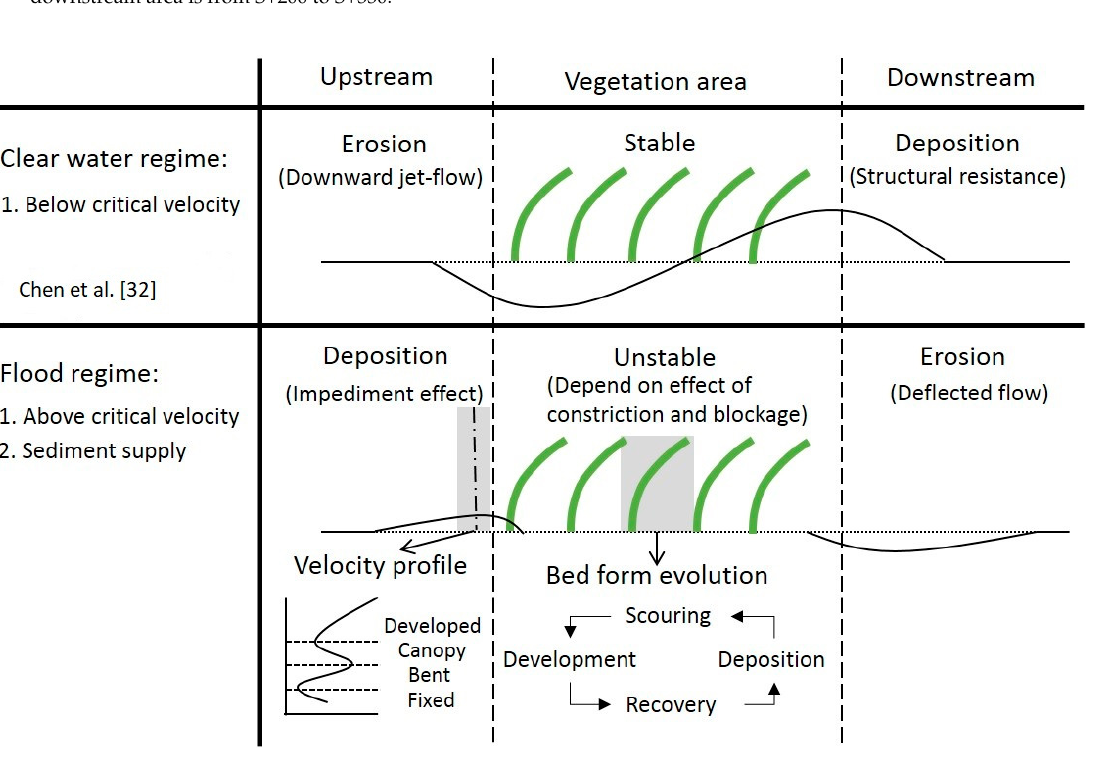
Figure 7. Schematic diagram of the clear water and sediment-laden flow.